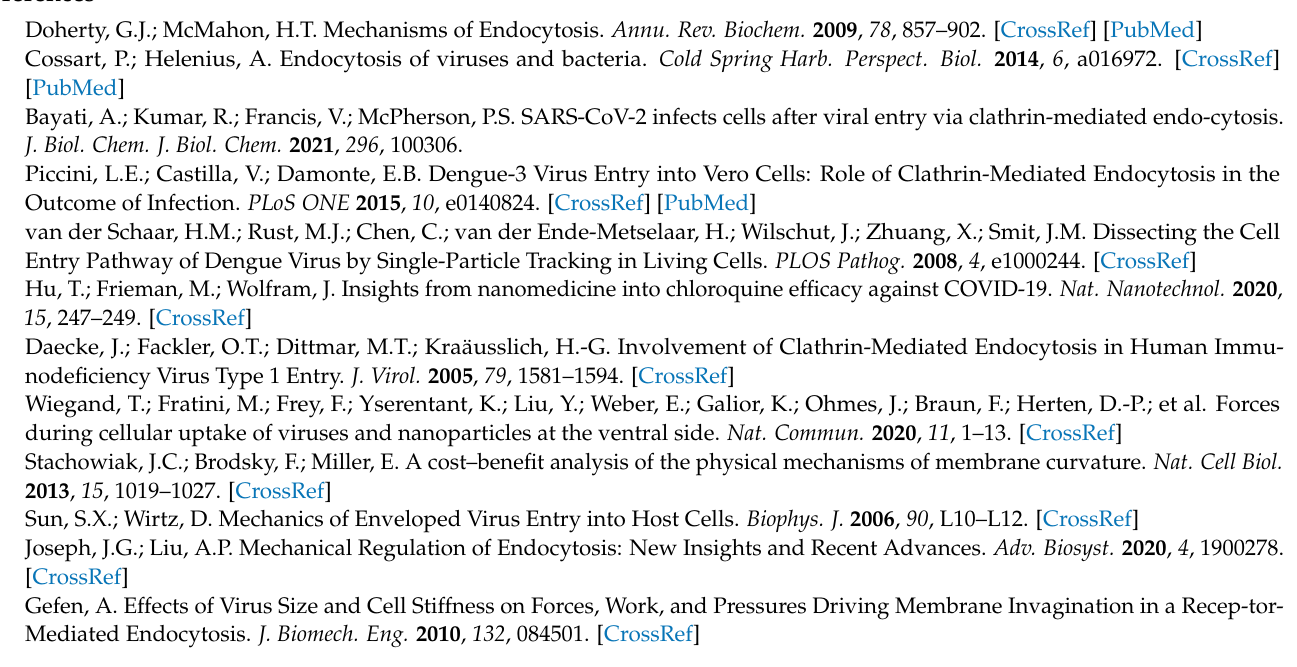
constructs; Figure S2: Spherical and filamentous IAV morphologies and labeling; Figure S3: IAV internalization visualized using lattice light sheet microscopy; Figure S4: Colocalization of spherical and filament-forming IAVs to CCSs; Table S1: Comparison of viral infectivity with or without DiD